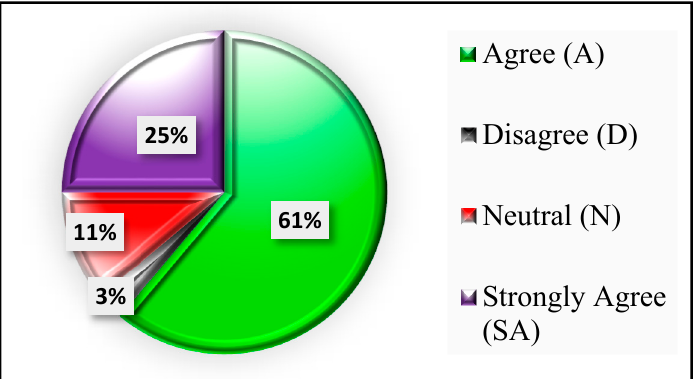
Figure 5. Complete set of precise, agile practices in the technical aspect .